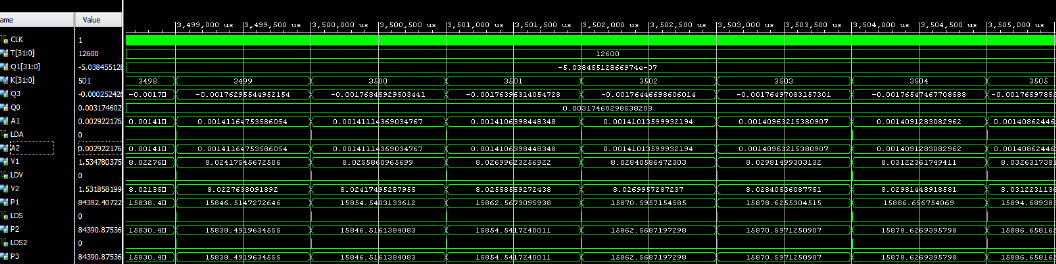
Figure A4. Simulation of change in values of acceleration, velocity and position for parbolic